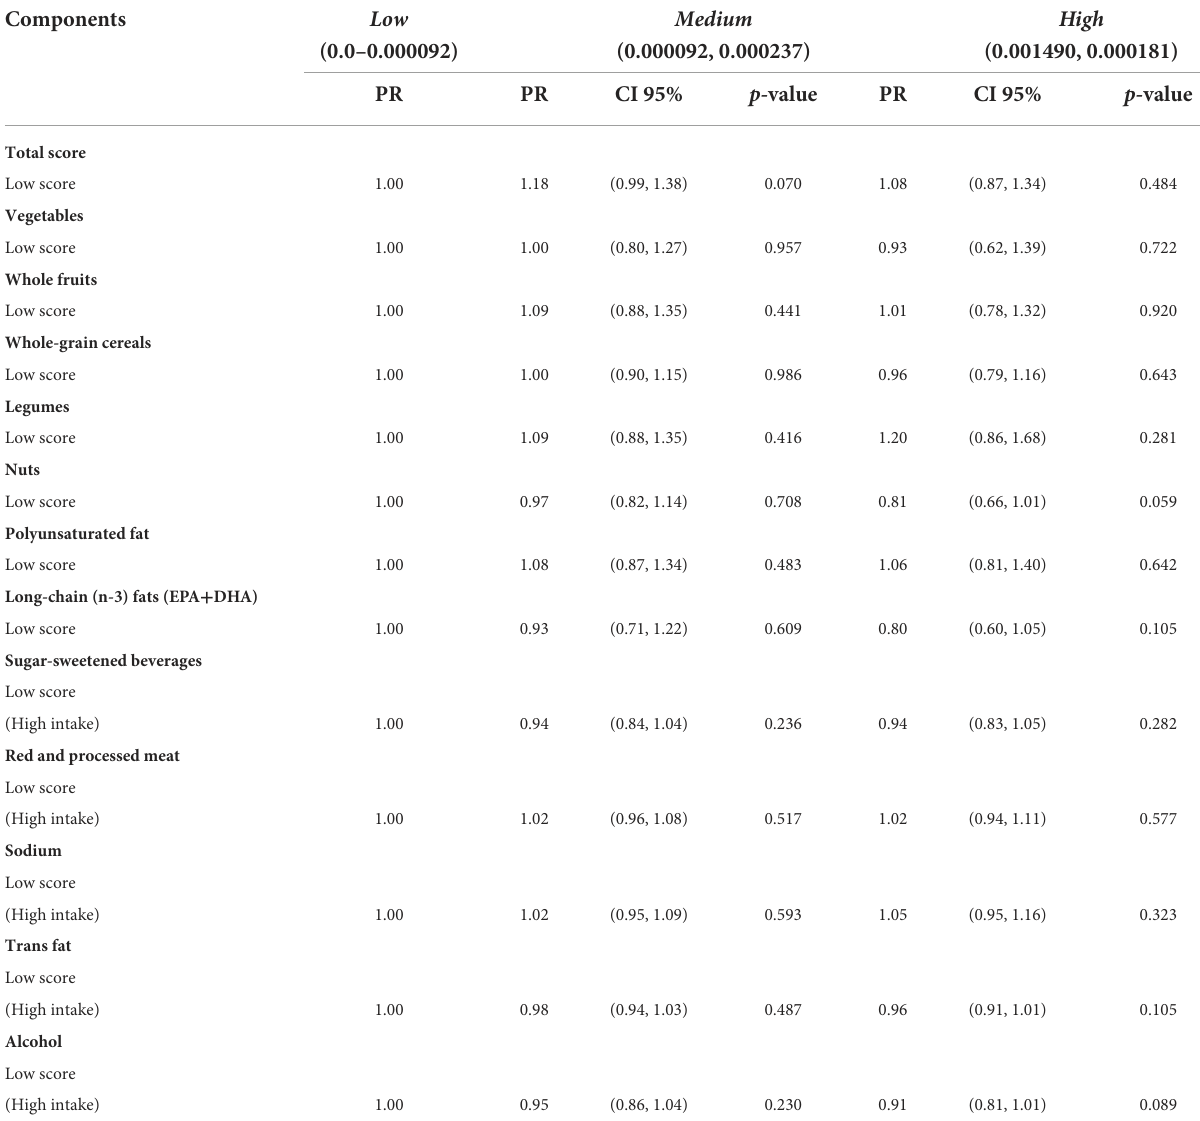
TABLE 3 Association between the density of grocery stores with Mexican Alternate Healthy Eating Index overall and components a . MxAHEI b Density of small grocery stores per Euclidean buffer c